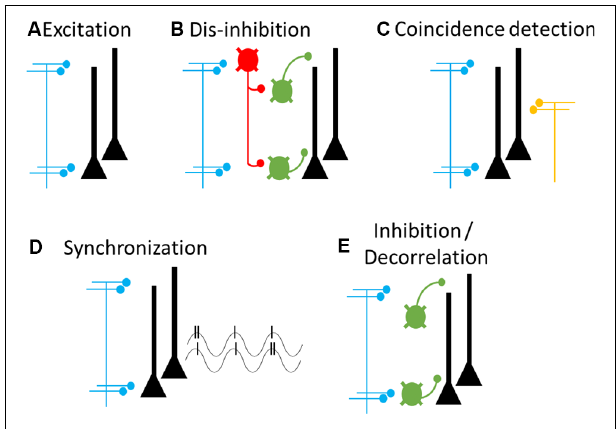
FIGURE 5 | Cellular and circuit mechanisms of cortical feedback modulation. Proposed cellular targets and mechanisms of cortical feedback pathways. Blue axons and terminals represent cortical feedback pathways, yellow axons and terminals represent feedforward pathways. Neurons in the target area include pyramidal neurons (black) and multiple types of GABAergic interneurons (green and red). (A) Cortical feedback forms excitatory synapses onto pyramidal neurons, leading to increased excitation. (B) Cortical feedback synapses onto interneuron-targeting GABAergic interneurons (red), leading to dis-inhibition. (C) Coincident inputs from feedforward and feedback pathways lead to dendritic spiking and supra-linear increases in pyramidal neuron output. (D) Phasic activity of cortical feedback leads to pyramidal neuron synchronization, both locally (shown here) and between source and